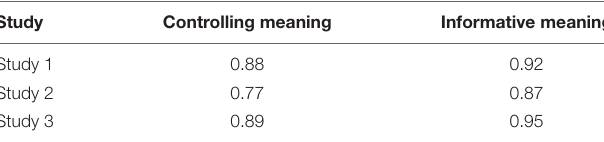
TABLE 4 | Internal consistencies of the controlling meaning and informative meaning scores among the three studies.